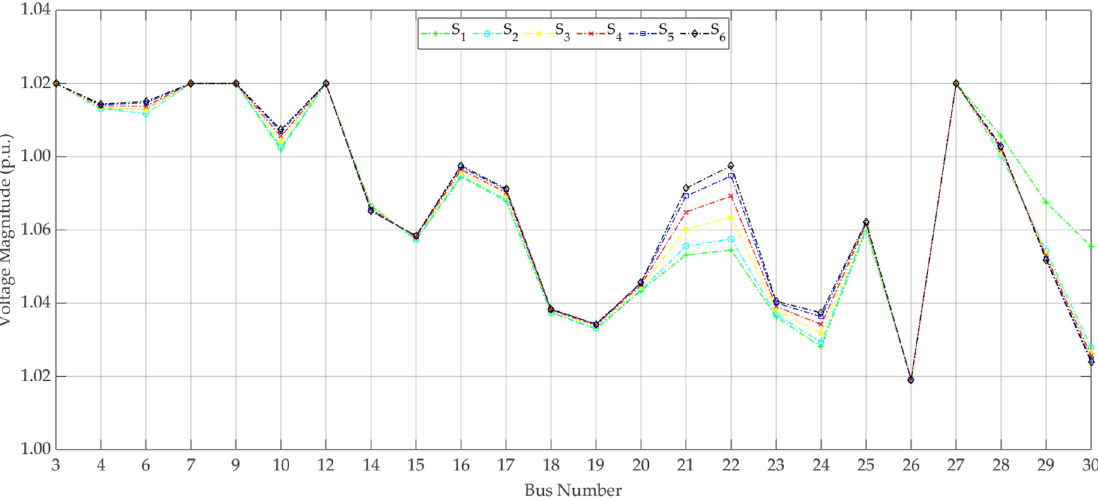
Figure 3. Voltage profile of the load buses for probabilistic multi-objective RPP considering the wind power generation uncertainty.